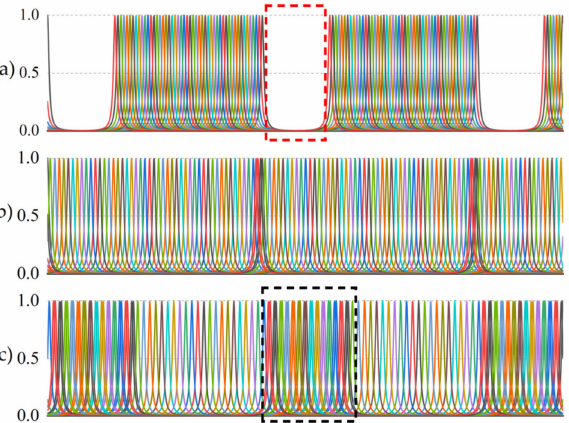
Figure 15. Sampling of a tunable FPI in ( a ) long-wavelength; ( b ) mid-wavelength; ( c ) short- wavelength